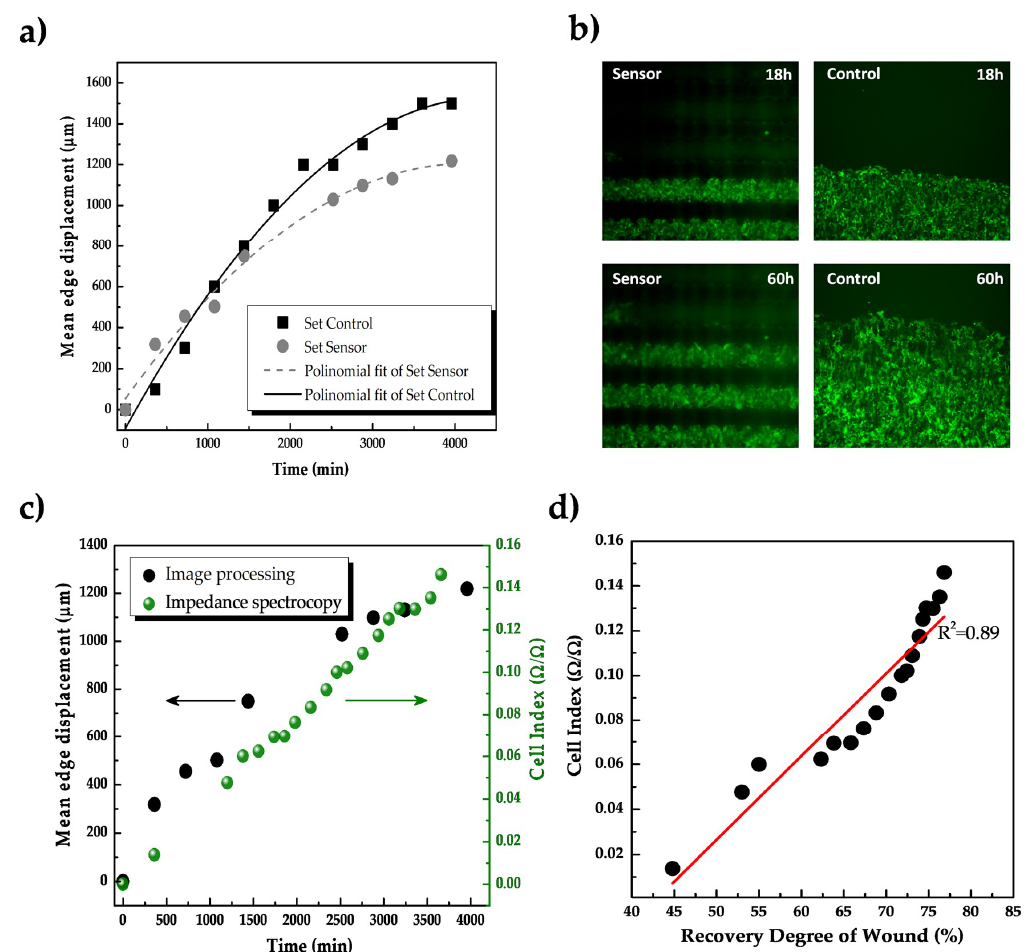
Figure 8. Monitoring of cell migration using real-time impedance spectroscopy. ( a ) Mean edge displacement of a monolayer of cell cultures in control groups (Petri dish) and experimental groups (cells seeded on the IDEs devices) during 4000 min of time-lapse observation. ( b ) Visualization of the experiment under a microscope. We can see how both for the sensors and the control cultures the cell edge advance towards the top of the figure in time (migration). Note how in the sensors culture the electrodes appear as dark stripes due to the opacity of the inks (illumination from below) ( c ) The relation between real-time impedance monitoring of cell migration and the displacement of cells by image processing of the microscope images. ( d ) Linear correlation between the cell index values and the recovery degree of wound healing, with a linear regression coe ffi cient R =